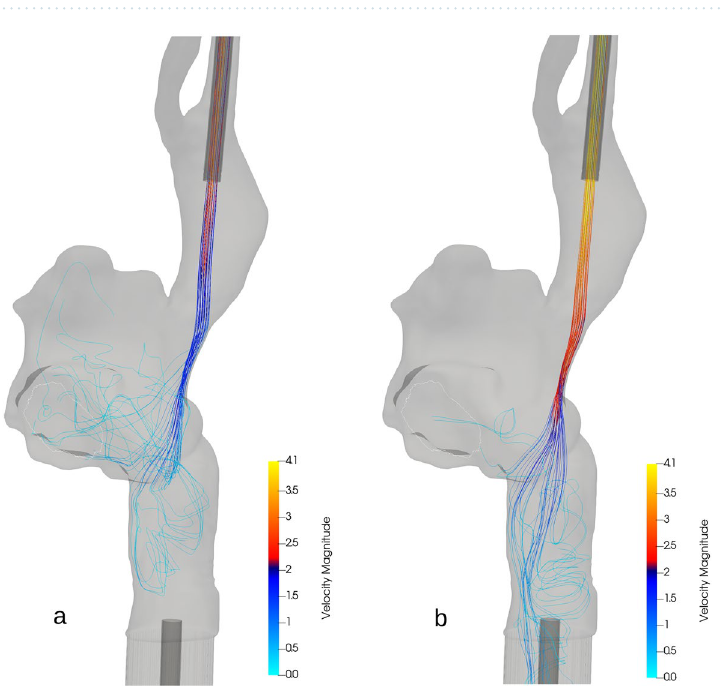
Figure 2. Saturation charts for the two different ECMO flows. Saturation levels at the Tricuspid valve for different cannula positions and the two considered ECMO flows. ( a ) 3 L/min. Mean: 83.12, standard deviation: 0.49. ( b ) 5 L / min . Mean: 92.21, standard deviation: 0.37. In both charts, the values span a small range, meaning that moving the cannulae influences the ECMO efficacy by less than 2% , hardly compensating the risk of generating an infection. On the other hand, the worst 5 L / min configuration performs much better than the best 3 L/min one, indicating that increasing the ECMO flow offers the most benefit.